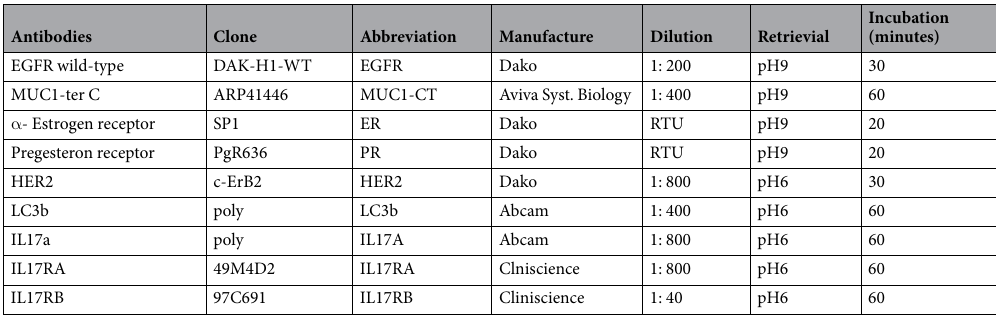
Table 1. Primary antibodies, dilution, antigenic retrieval, incubation times and abbreviations used in this